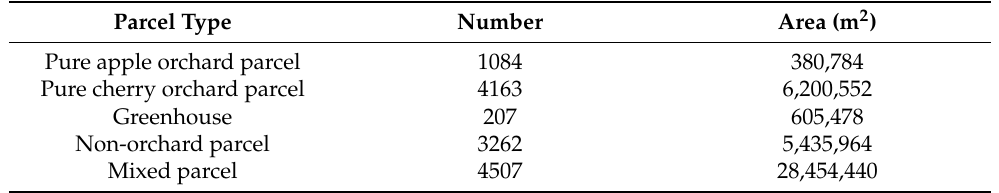
Table 4. Information obtained from different types of parcels. Parcel